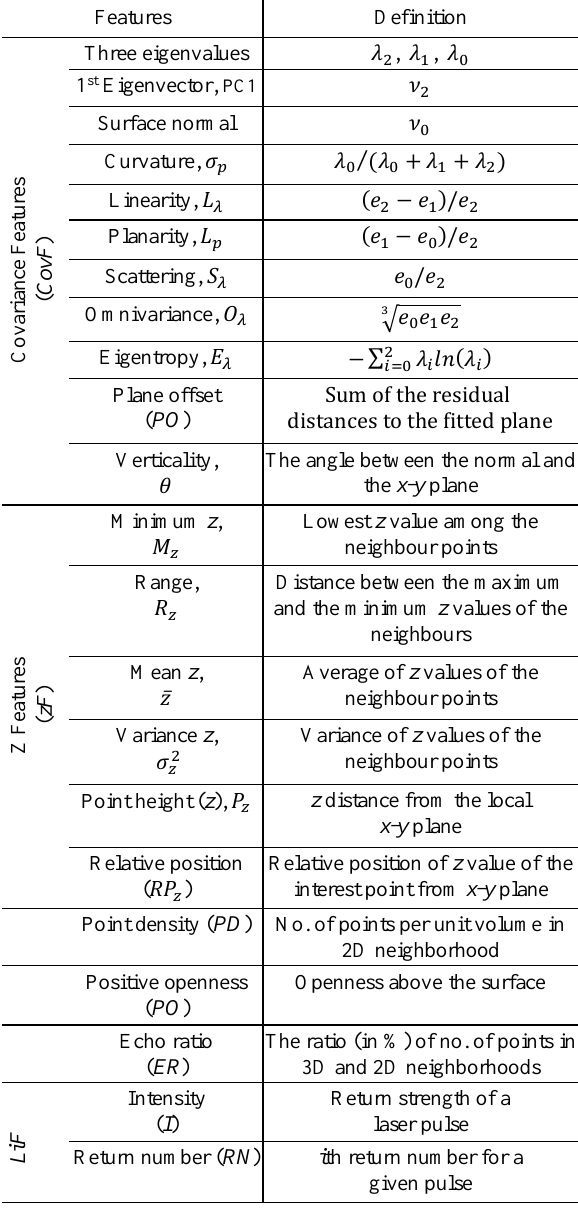
Table 1. Extracted features used in the proposed network.